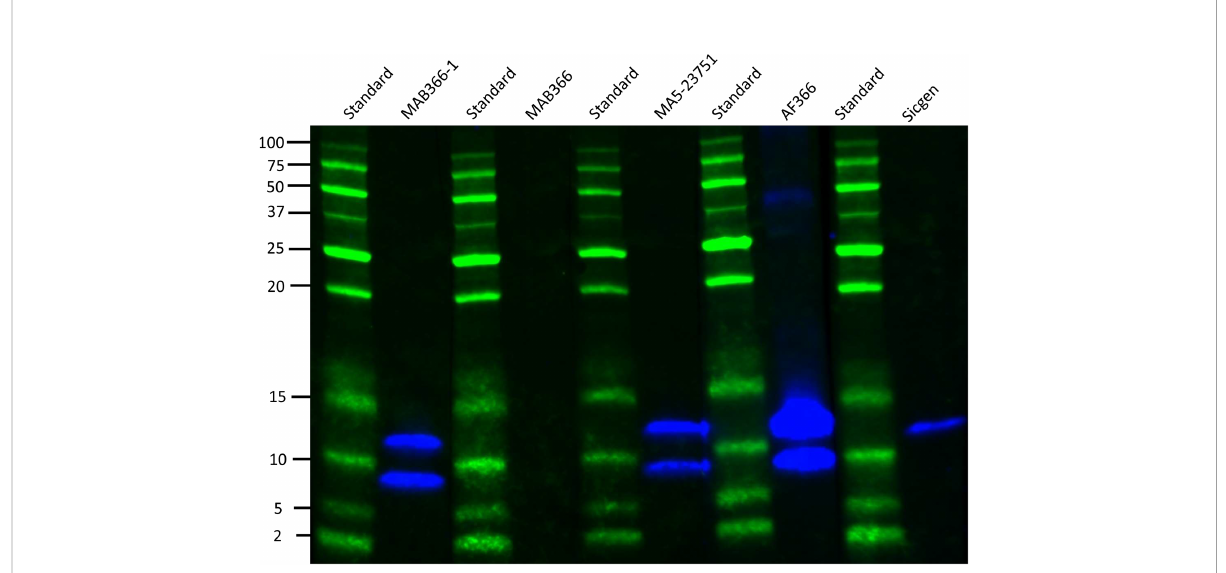
FIGURE 8 Test of CCL21-antibodies using Western blot analysis. The Western blot analysis showed that three of the CCL21 antibodies detected both full length and tailless CCL21 (four left lanes). The custom-made anti-C-terminal tail of CCL21 antibody from Sicgen only detected full length CCL21 (right